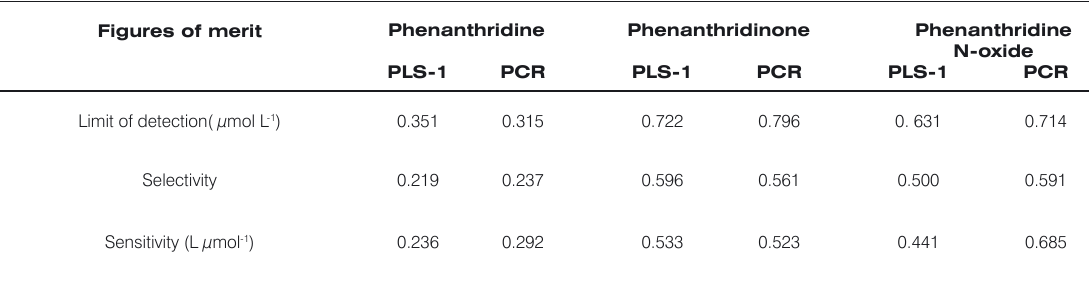
Table 3. Multivariate analytical figures of merit for phenanthridine, phenanthridinone and phenanthridine N-oxide